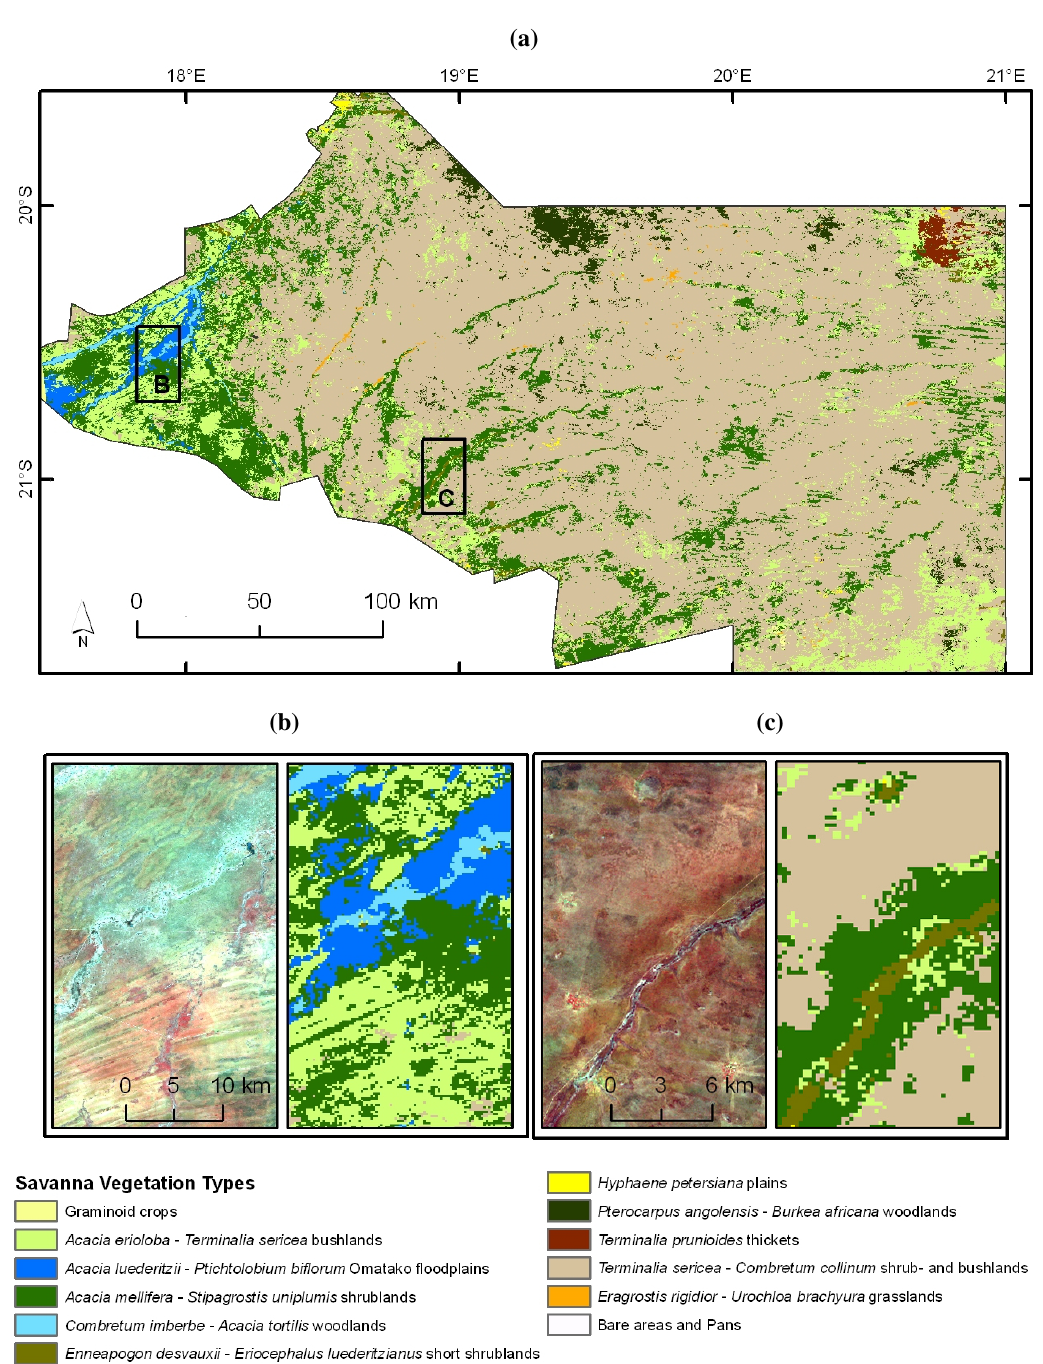
Figure 5. Vegetation type classification derived from inter-annual MODIS time series metrics (2001–2007) based on Random Forest classification. The vegetation type map is shown in 5a. 5b and 5c show the classification result for examples of the Omatako River region (Box B) and an Omarumba valley cut deep into Kalahari sands (Box C), 5b and 5c are compared to Landsat-TM images